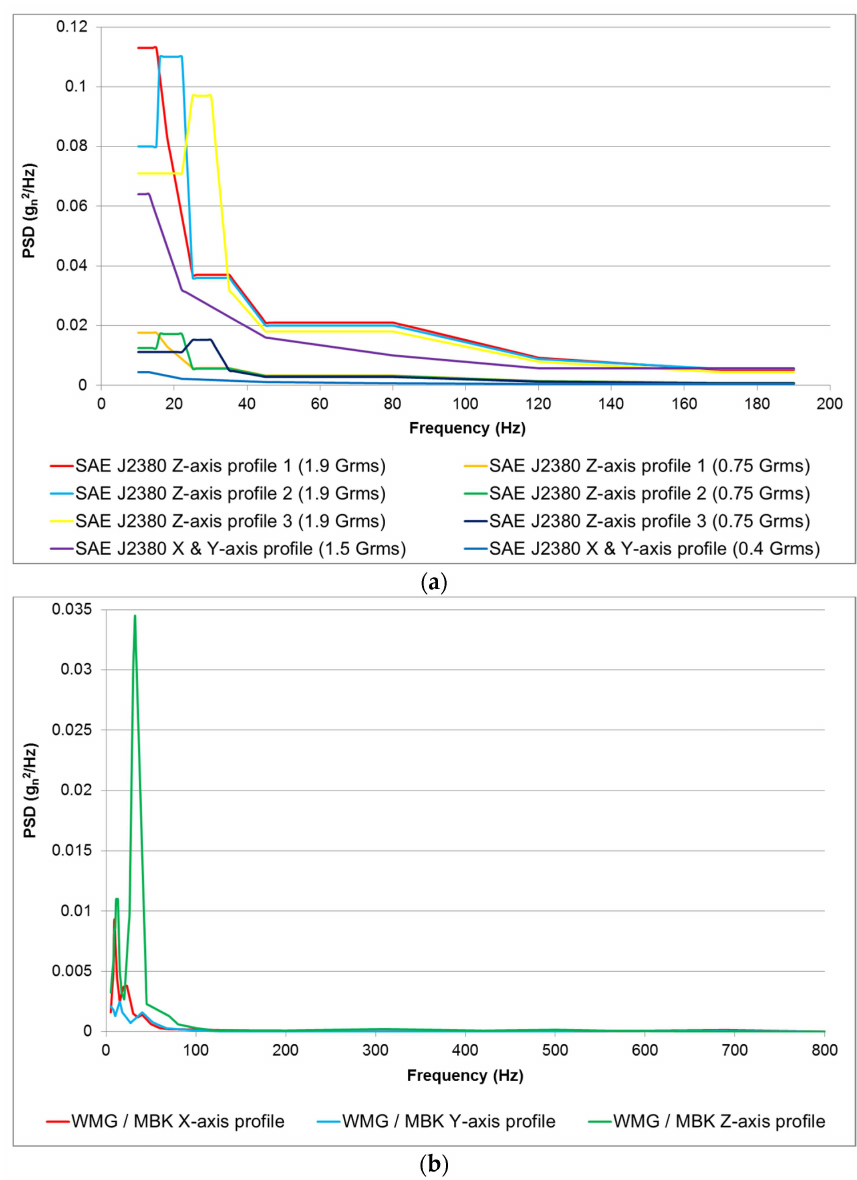
Figure 6. ( a ) SAE J2380 vibration power spectral density (PSD) profiles for testing samples 10 to 18; ( b ) Warwick Manufacturing Group/Millbrook Proving Ground WMG/MBK vibration PSD profiles for testing samples 19 to